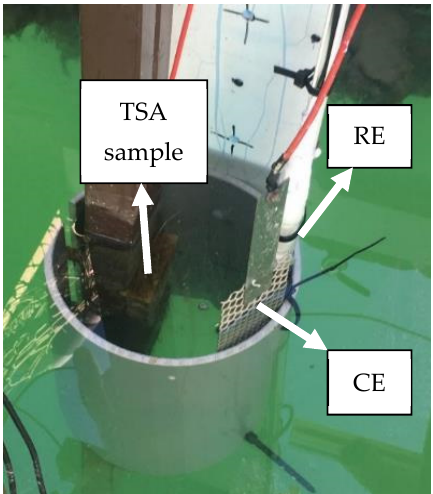
Figure 2. Experimental setup to carry out electrochemical measurements at Les Minimes (La Rochelle, France).